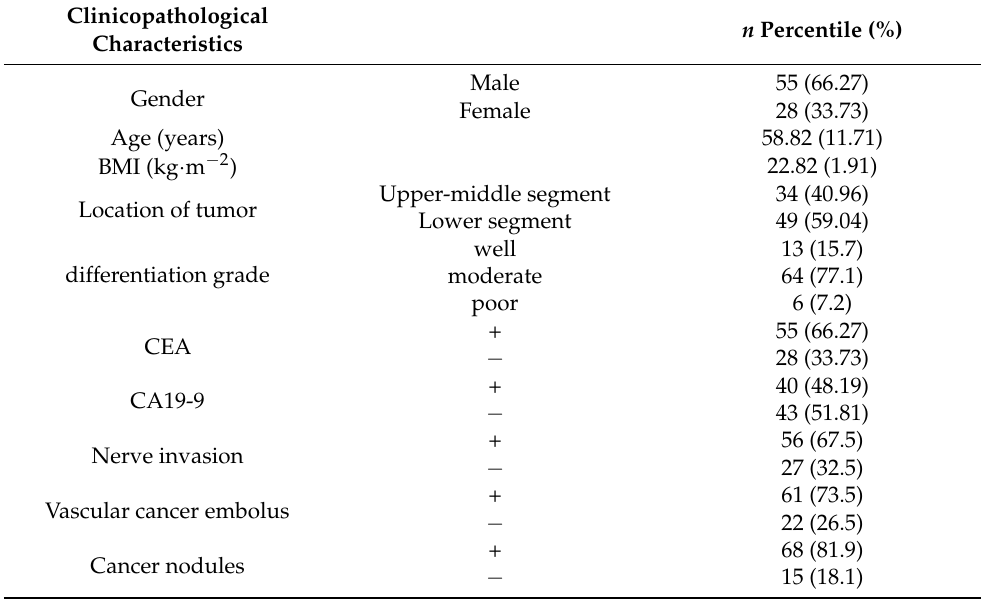
Table 2. Clinicopathological characteristics of the